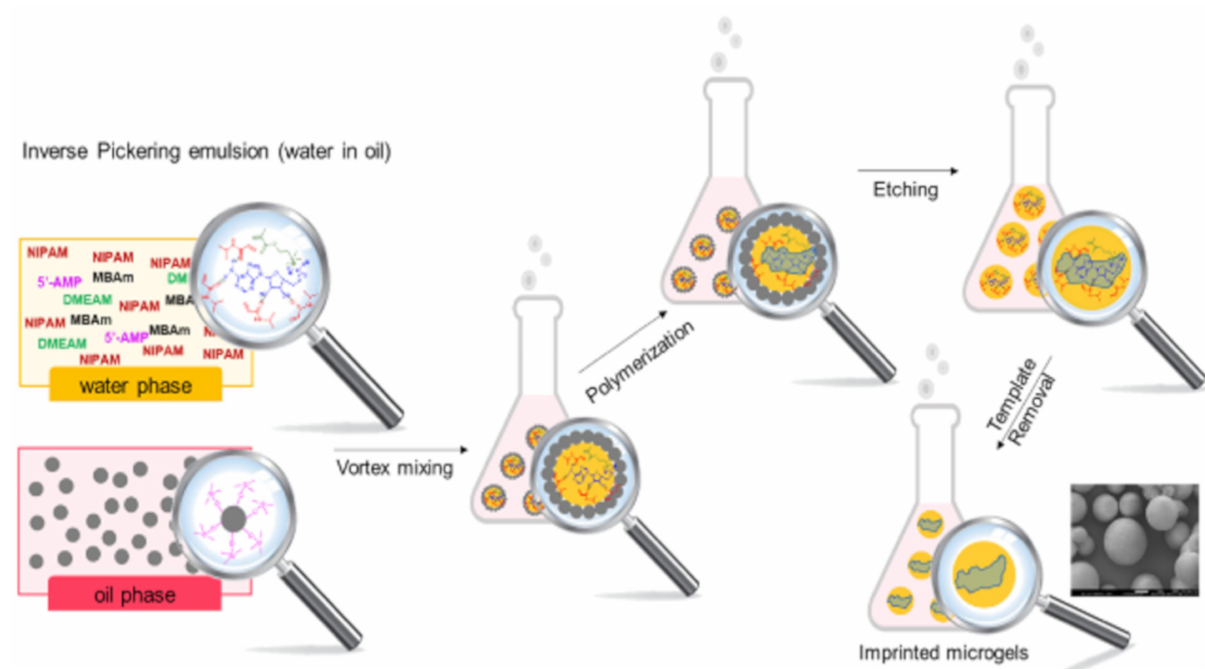
Figure 3. Inverse Pickering emulsion used for the synthesis of MIP-DMEAM-NIPAM-based hydrogel microbeads. Repro- duced with permission. [56] © 2021 Elsevier